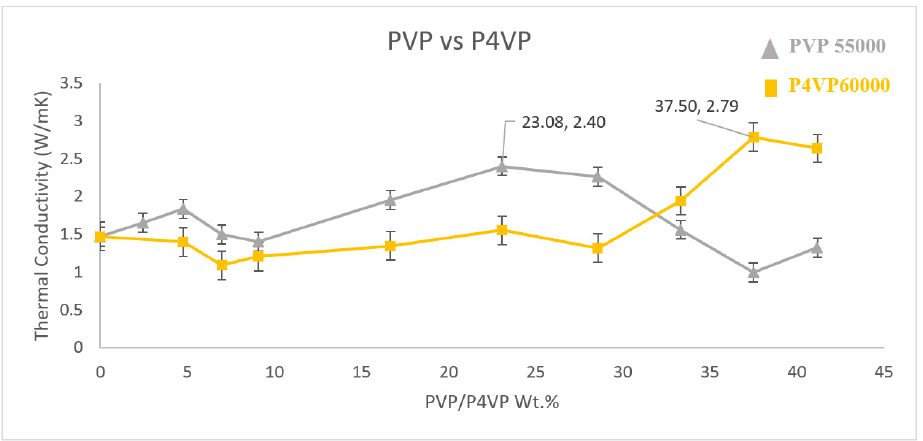
Figure 8. Thermal conductivity measure of PVP and P4VP functionalised MWNT/PVDF composite.